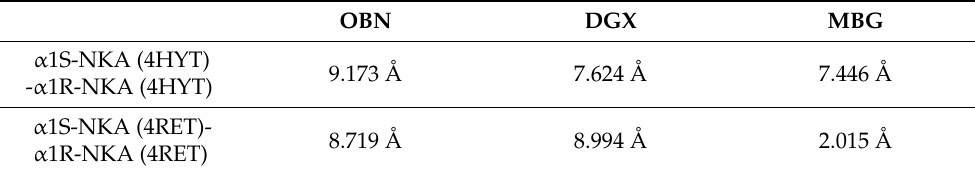
(Table 2, Figure 3, Figure 4 and Figure S2). The predicted binding energy was lower in the complexes with the α 1R-NKA model (Table 3). The number of contacts of CTSs with protein was higher in complexes with α 1S-NKA than in the α 1R-NKA model. Similar amino acid residues involved in interactions with CTSs were found in both α 1S-NKA and α 1R-NKA models (Table 4). It should be noted that after substitution of Gln111 and Asn122 in α 1R-NKA with charged amino acids (Arg and Asp), amino acid residue 122 in CTS-resistant form did not participate in the interaction with the ligands in contrast to amino acid residue 111, which continue to interact with CTS. Table 2. Difference in the deepening of the steroid nucleus of cardiotonic steroids between α 1S- Na,K-ATPase and α 1R-Na,K-ATPase. The distance was measured from C23 of the ligand docked to α 1S- Na,K-ATPase (4HYT) to the C23 of the ligand docked to α 1R- Na,K-ATPase (4HYT). OBN DGX MBG α 1S-NKA (4HYT)